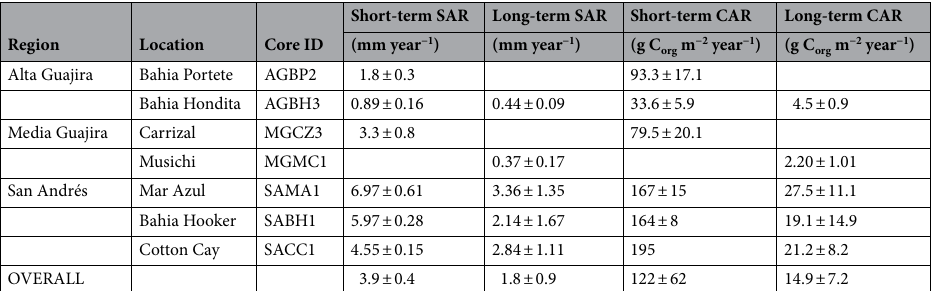
Table 2. Mean (± SD) short-term (last decades) and long-term (last 2000 years) sediment accumulation rates (SAR; mm year −1 ) and organic carbon accumulation rates (CAR; g C org m −2 year −1 ) in seagrass soils from all cores successfully dated in the different locations and regions in the Colombian Caribbean.